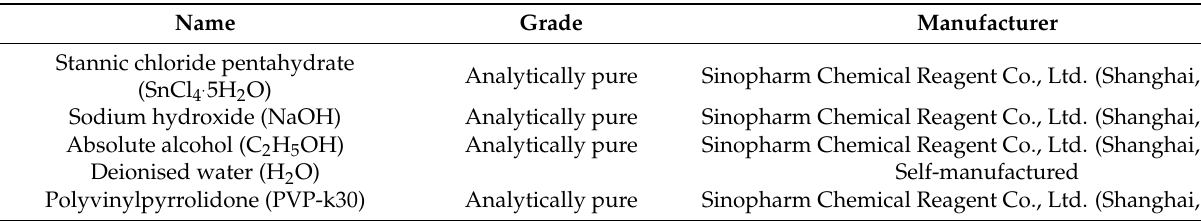
Table 1. Raw materials and